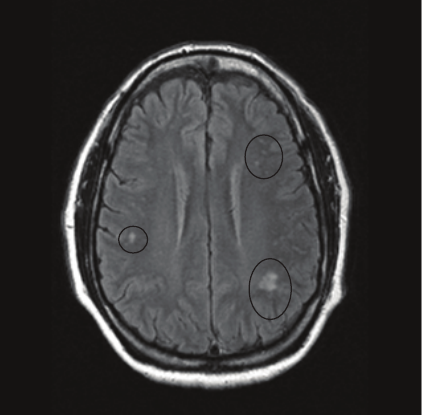
Figure 2: MRI image of the brain in an axial view showing the “post-contrast FLAIR image”. Note the abnormallesions(circled) in the per ventricular area do not showany enhancement with contrast injection.